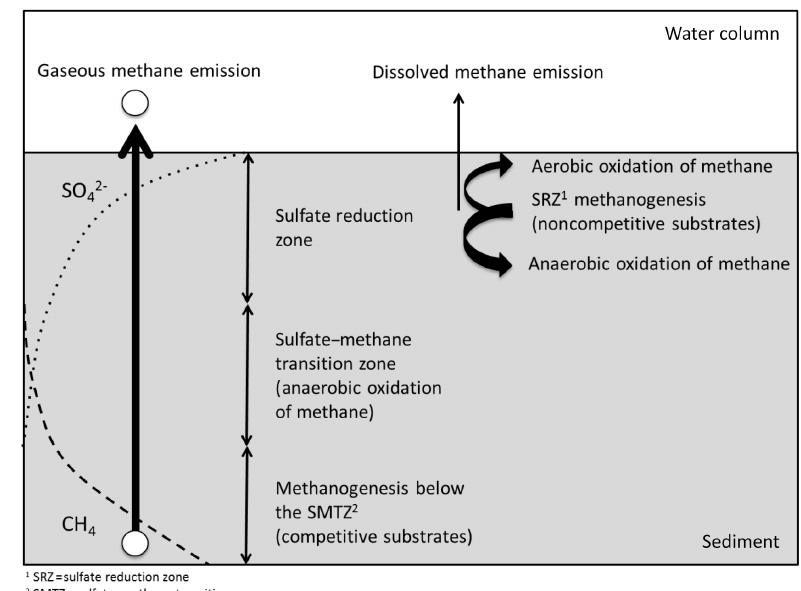
Figure 1. Overview of processes relevant for benthic methane production, consumption, and emission in the Eckernförde Bay. The thickness of arrows for emissions and coupling between surface processes indicates the strength of methane supply. Note that this figure combines existing knowledge with results from the present study. See discussion for more